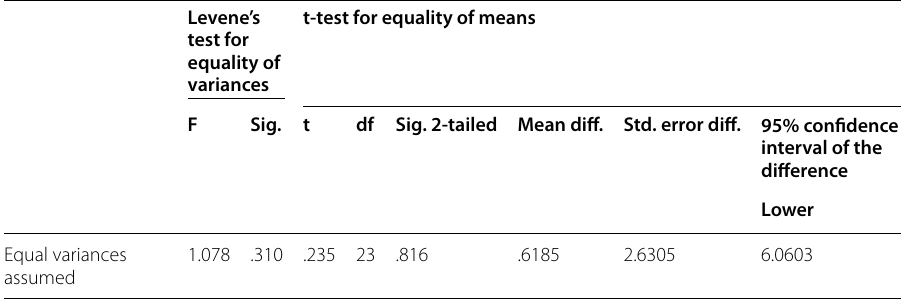
Table 8 Independent samples T-test between ectenic and synoptic learners in PI Group, posttest Levene’s t-test for equality of test for equality of variances